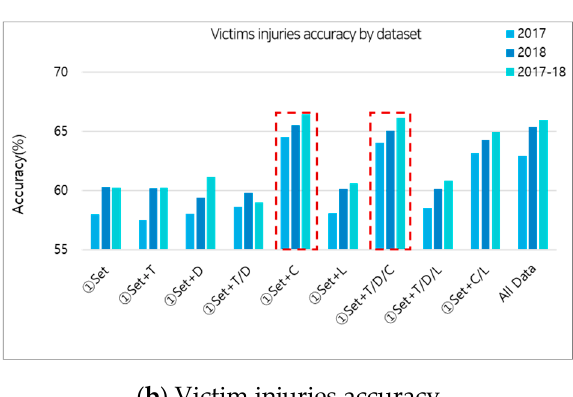
Figure 1. ( a ) Offender Injuries Accuracy by dataset; and ( b ) Victim Injuries Accuracy by dataset: The red dash line rectangular stands for the highest accuracy at that factors in 2017–2018 Table 4. Offender/Victim Injuries Accuracy by datasets.